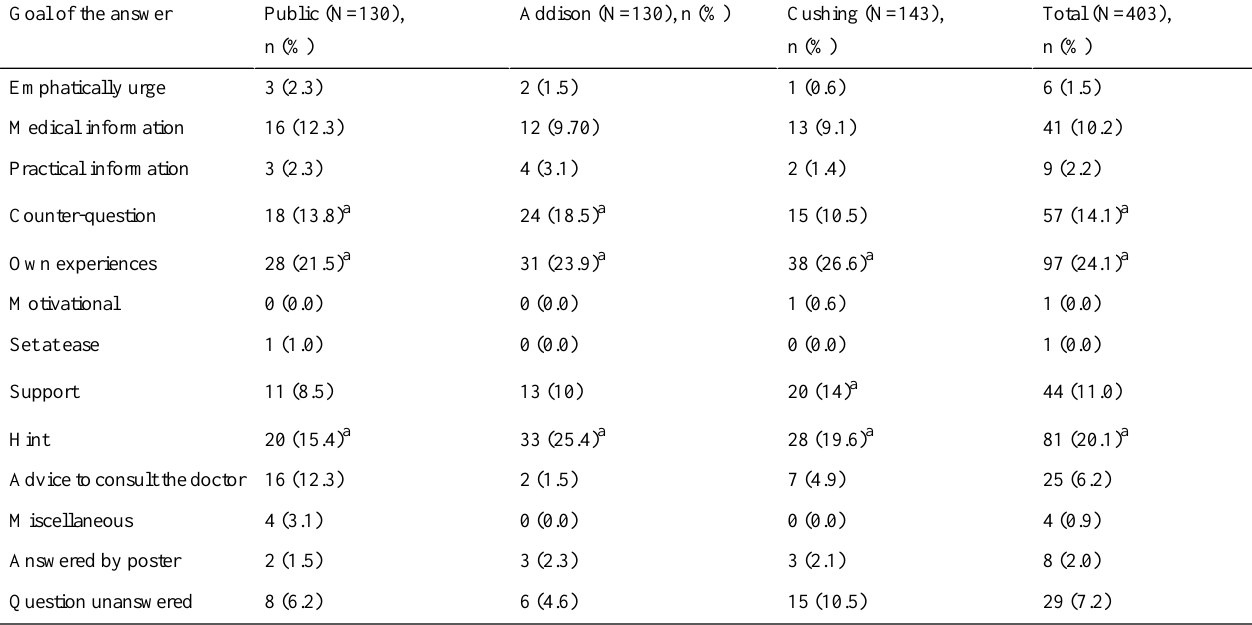
Table 2. Total amount of answers, categorized per theme.